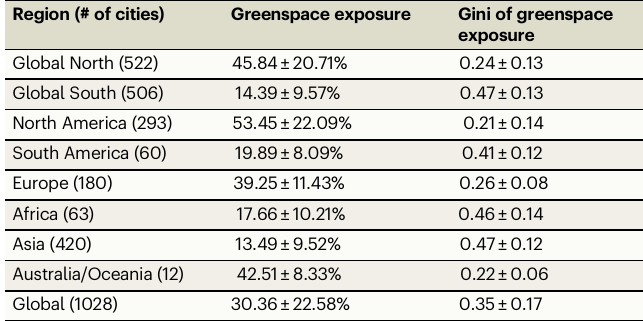
Table 1 | Statistics of city-level human exposure to green- space and greenspace exposure inequality across regions Region (# of cities) Greenspace exposure